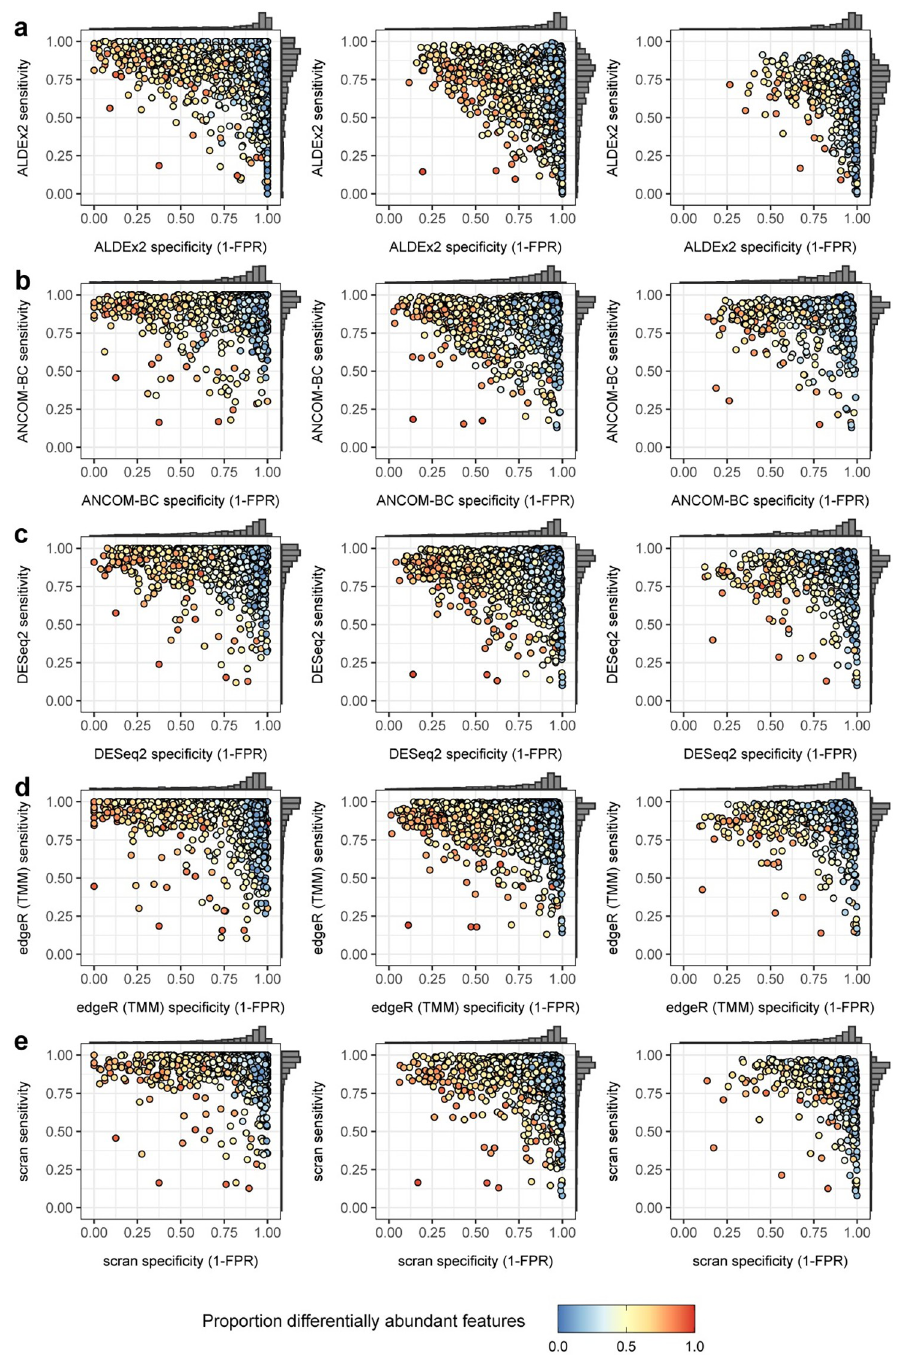
Fig 1. Simulated sensitivity and specificity as a function of setting and proportion of differentially abundant features. Sensitivity and specificity for five differential abundance calling methods in three experimental settings: a) Microbial, b) Bulk Transcriptomic, and c) Cell Transcriptomic settings. Data sets are labeled by proportion of differentially abundant features.